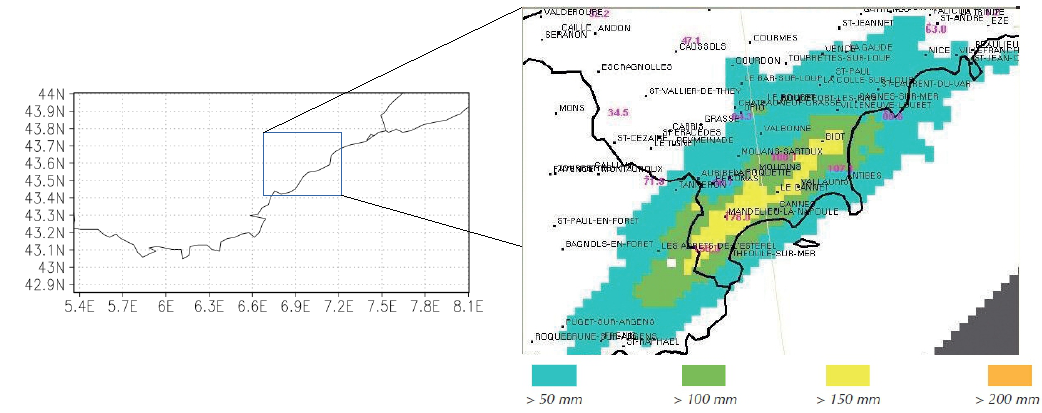
Figure 5. Extension of the innermost simulation domain adopted in this study and of the area affected by severe convection ( left ) and rain accumulations (mm) provided by the ANTILOPE analysis between 17 UTC and 20 UTC, 3 October 2015 ( right ). ANTILOPE product is based on both radar data and measurements from the rain gauge network (Meteo France).